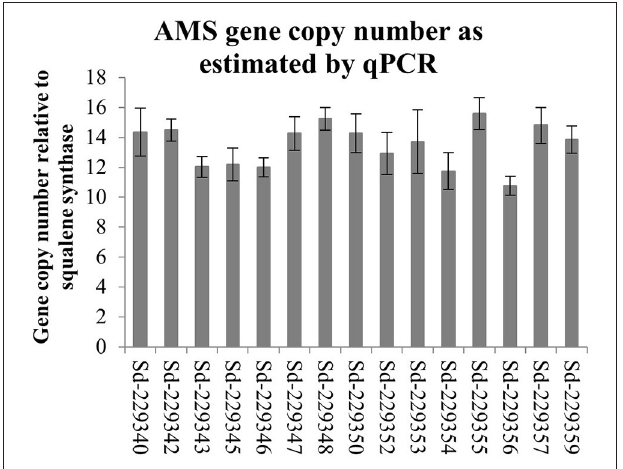
FIGURE 2 | AMS gene copy number in 15 individual lines of the A. annua cultivar Artemis estimated by qPCR. Error bars represent standard error ( n = 4). Sd prefixed numbers represent individual Artemis plants.